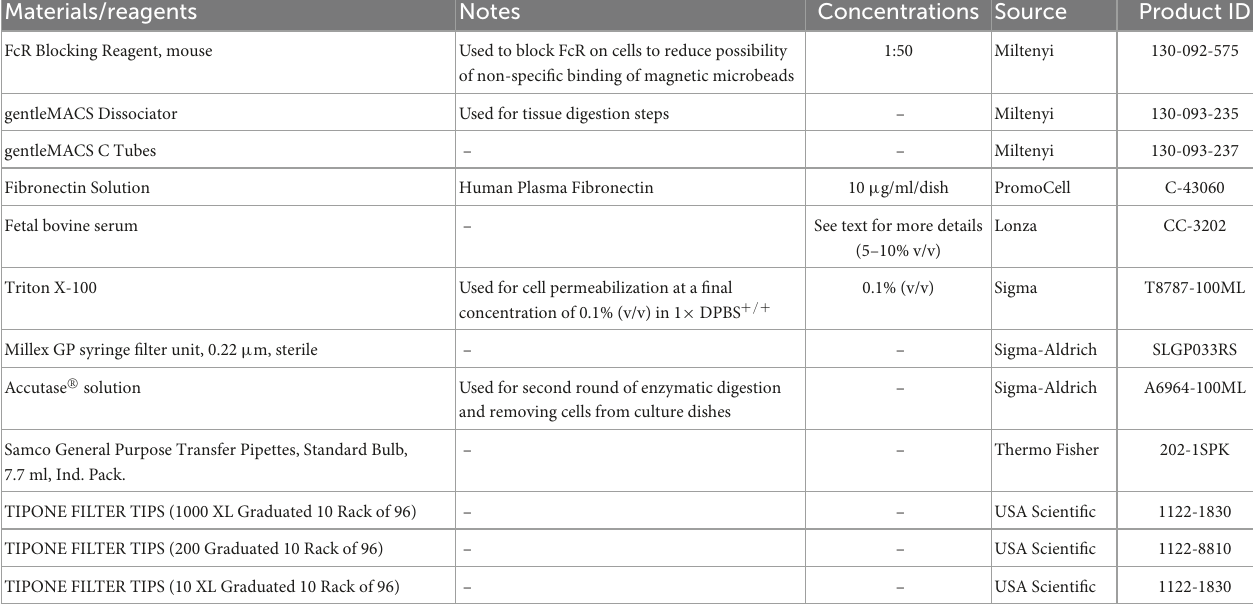
Table 1 for the exact solution compositions, considerations, and